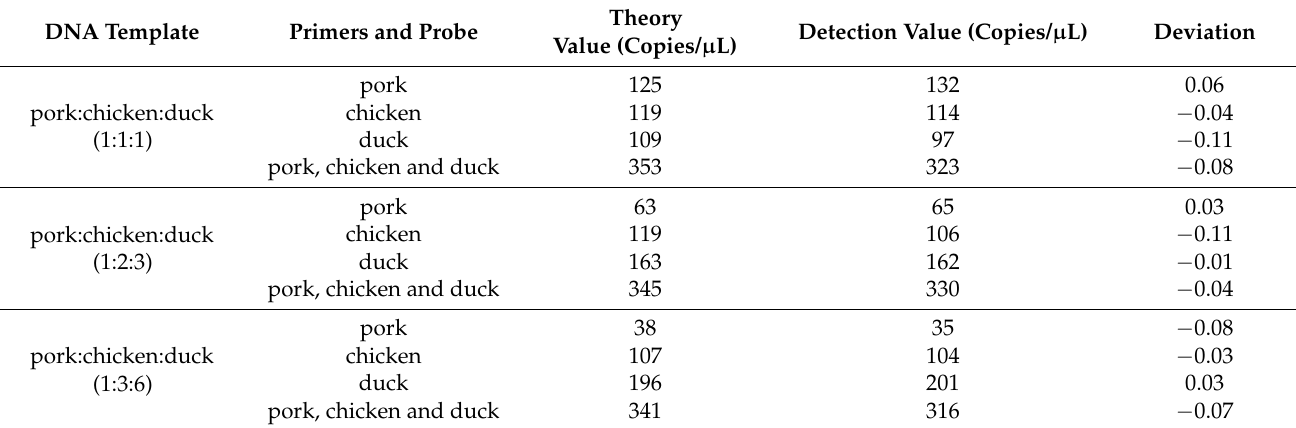
Table 6. Measured values of ddPCR for pork, chicken and duck. DNA